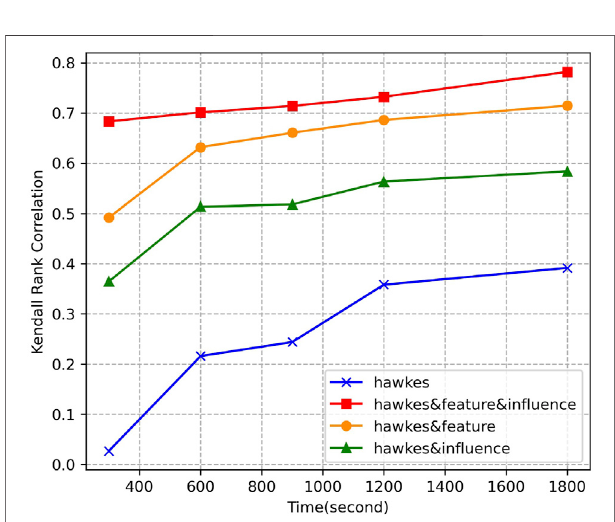
FIGURE 7 | Comparison of Kendall rank correlation for different models on dataset